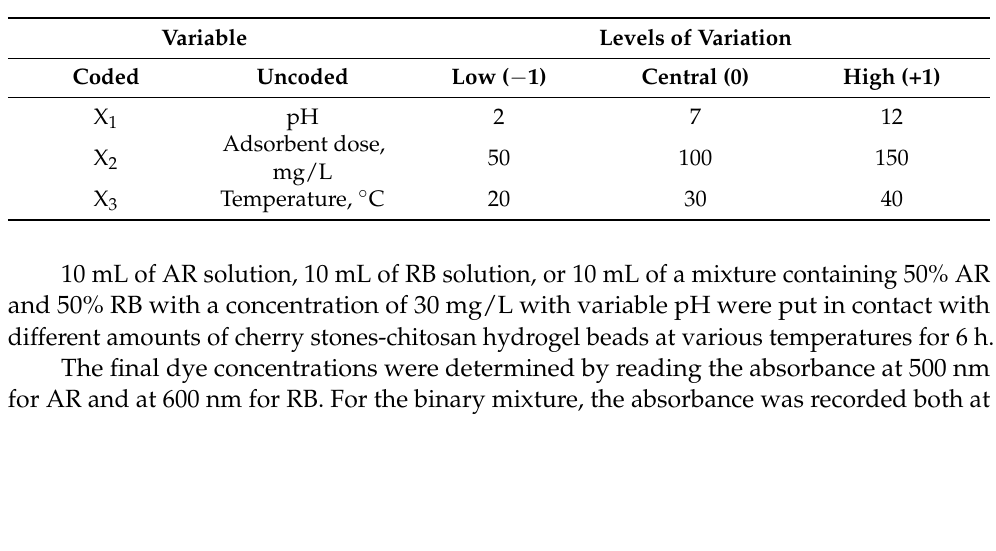
Table 8. Variables and levels of variation in